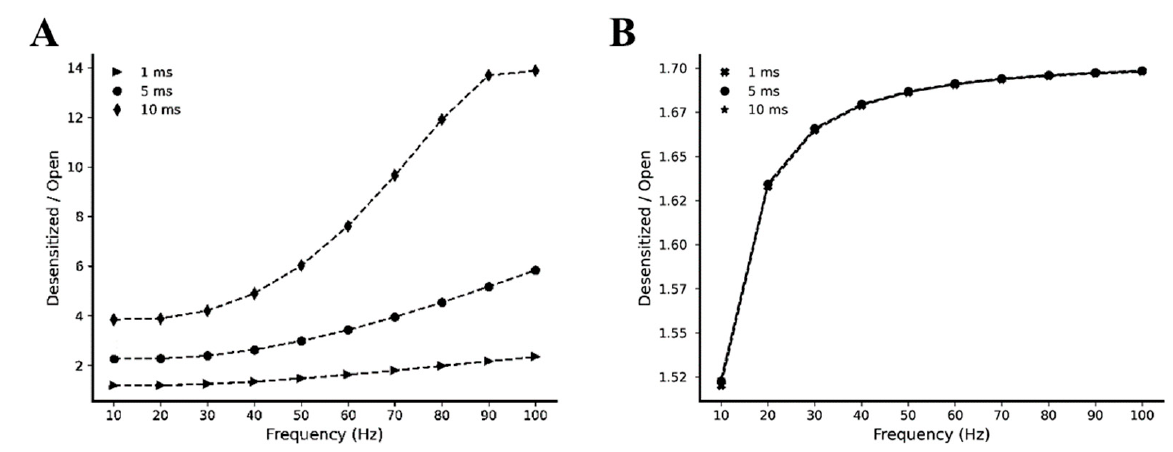
Figure 5. Desensitized/Open ratio expressed as a function of stimulation frequency. Simulations were performed using single pre-synaptic glutamate pulses of 1 mM amplitude and 1, 5, and 10 ms width. For each simulation, the ratio between the desensitized and the open fraction has been calculated for ( A ) AMPA (triangles, circles and diamonds symbols refer, respectively, to 1, 5 and 10 ms pulse width) and ( B ) NMDA receptors (crosses, circles and stars symbols refer, respectively, to 1, 5 and 10 ms pulse width).